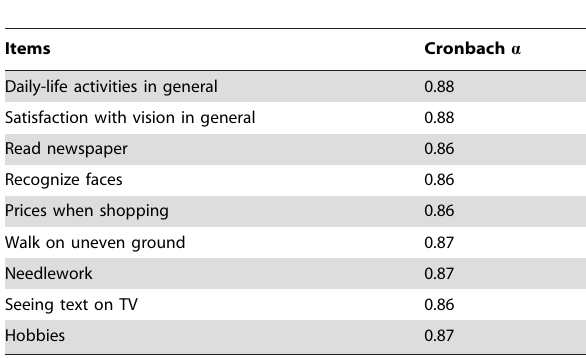
Table 4. Internal consistency of the Catquest-9SF